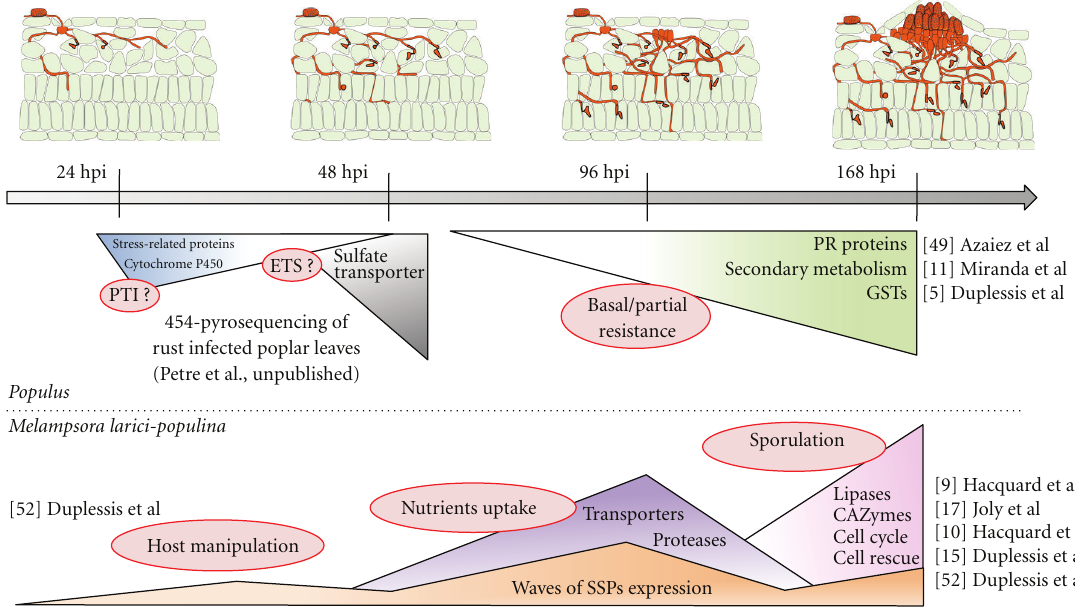
Figure 3: Major transcriptome regulations in a compatible Populus/Melampsora interaction. Triangles represent genetic programs set up by Populus (top) or M. larici-populina (bottom), and red circles indicate associated biological functions. PTI: PAMP-triggered immunity; ETS: e ff ector-triggered susceptibility; PR: pathogenesis-related; GSTs: glutathione S-transferases; hpi: hours postinoculation, CAZymes: carbohydrate-active enzymes, SSPs: small secreted